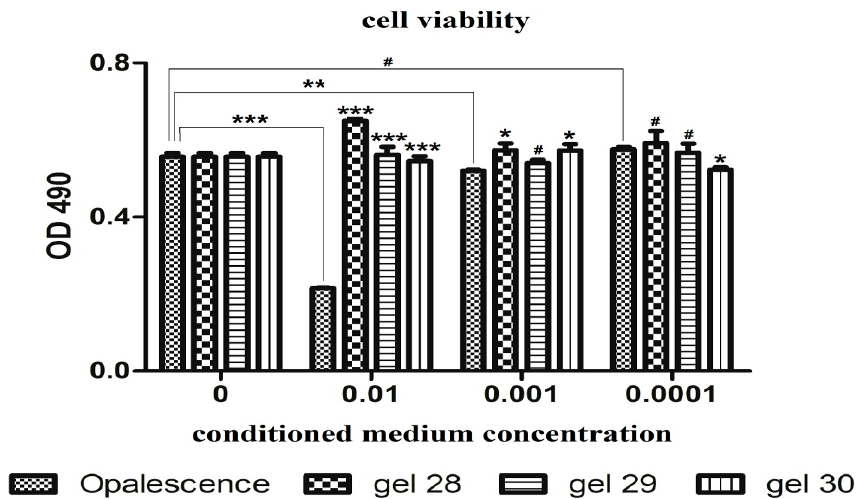
Figure 7. Cell viability for the four tested gels as a function of gel concentration in the conditioned medium comparative diagrams of cell viability of dental follicle stem cells following exposure to Opalescence, experimental gels 28, 29 and 30 (0.01–0.0001 dilutions of the conditioned medium) (upper panel); Each bar represents mean ± standard deviation (n = 3); # not significant, * p < 0.05; ** p < 0.01, *** p < 0.001, compared to Opalescence (upper panel).